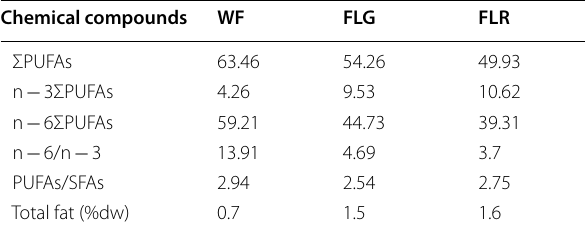
lysed samples by GC/MS-FID analysis. Fatty acid profile